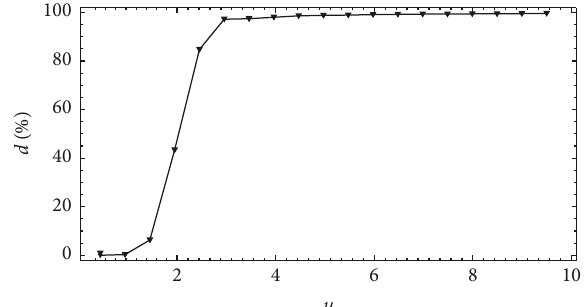
Figure 4: The crossing probability for pedestrians for different theoretical times of vehicles (the number of pedestrians is 20; the total sample size is